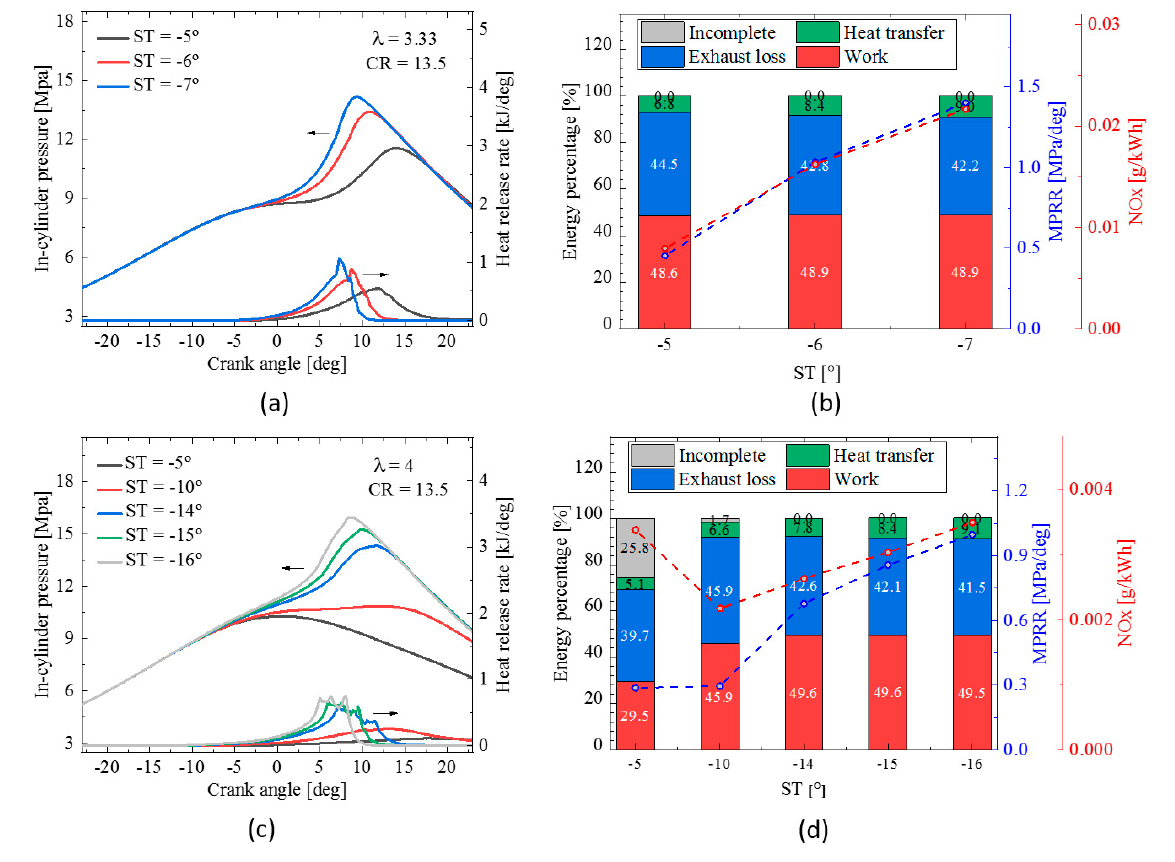
Figure 11. Comparison of: ( a ) pressure and heat release rate traces; ( b ) efficiency for and λ = 3.33; ( c ) pressure trace and heat release rate traces; and ( d ) efficiency for λ = 4 all set at CR =13.5 using different STs.